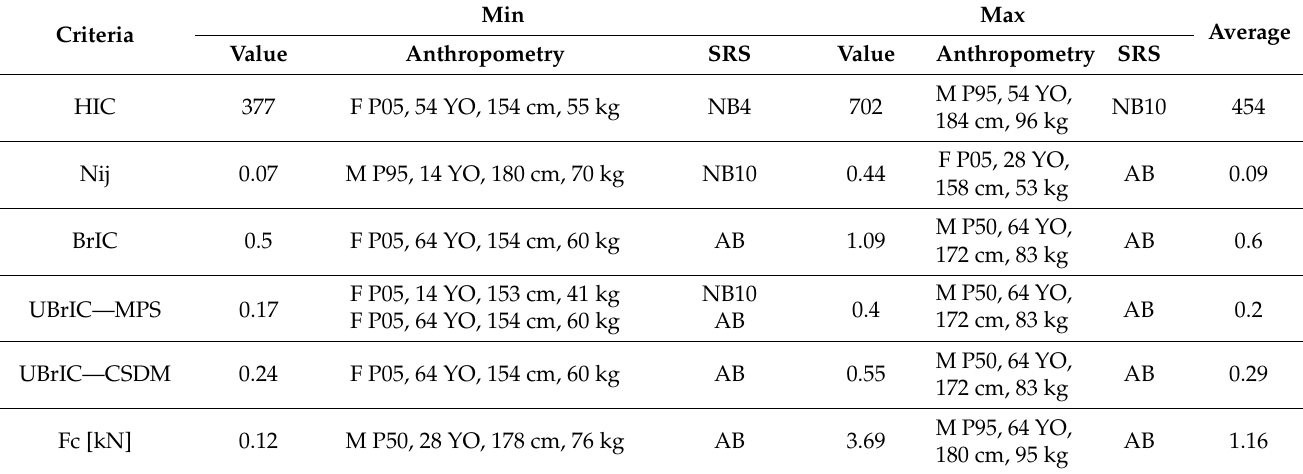
Table 5. Summary of the extreme values of the particular criteria for 50